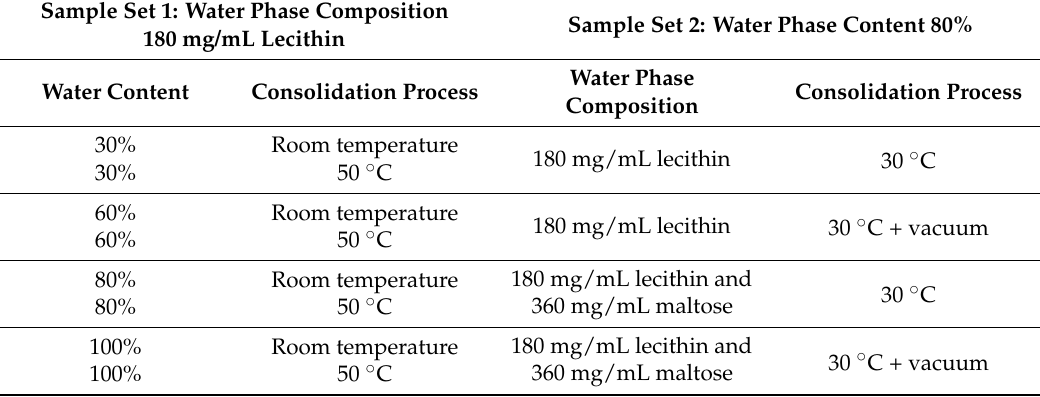
Table 1. Summary of process parameters for each